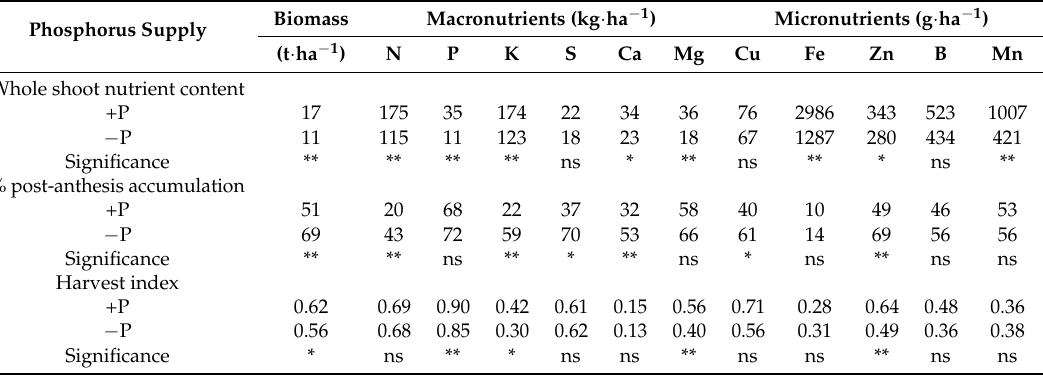
Table 1. Aboveground biomass and nutrient accumulation, harvest indices, and % post-anthesis accumulation of biomass and key nutrients in rice under Phosphorus (P)-deficient and P-fertilised growing conditions in the field. Significant differences are denoted by * ( p < 0.1), ** ( p < 0.05), or ns (not significantly different at p =